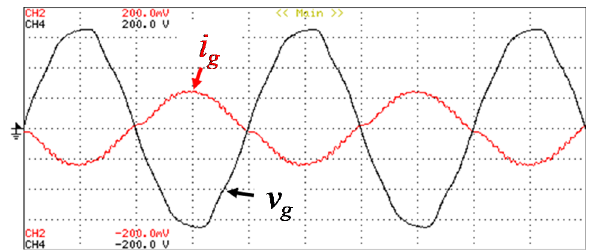
Figure 17. Experimental results during the MF-EVCS operation in R2G mode combined with V2G